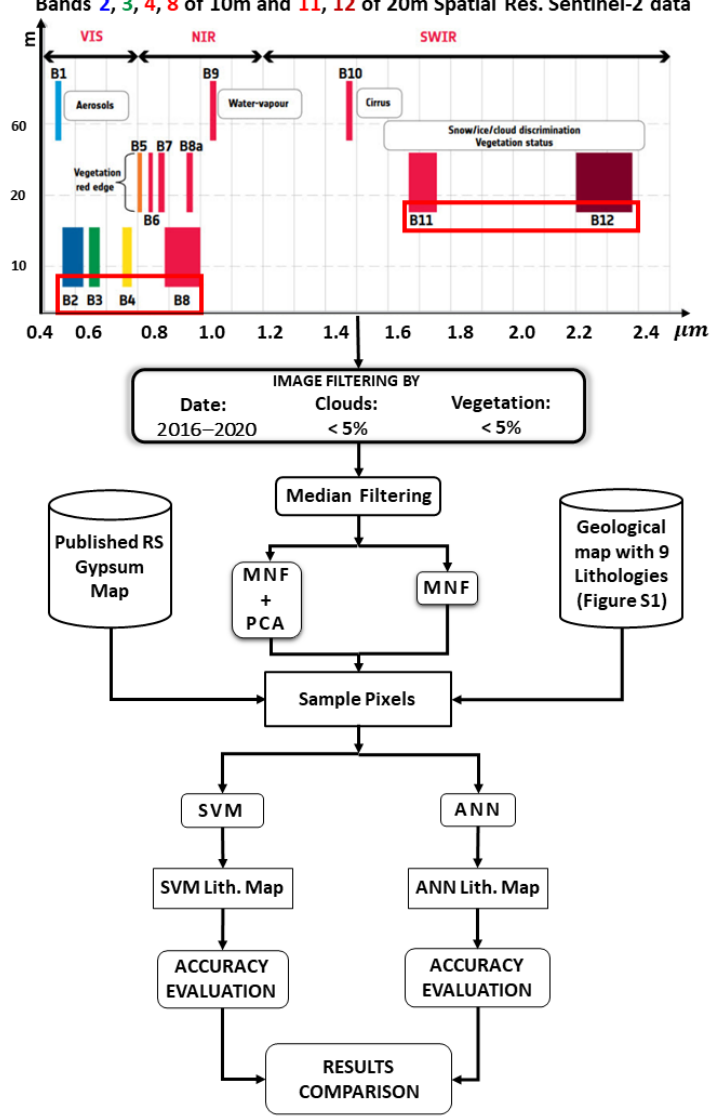
Figure 3. Block diagram of lithological classification applied in the